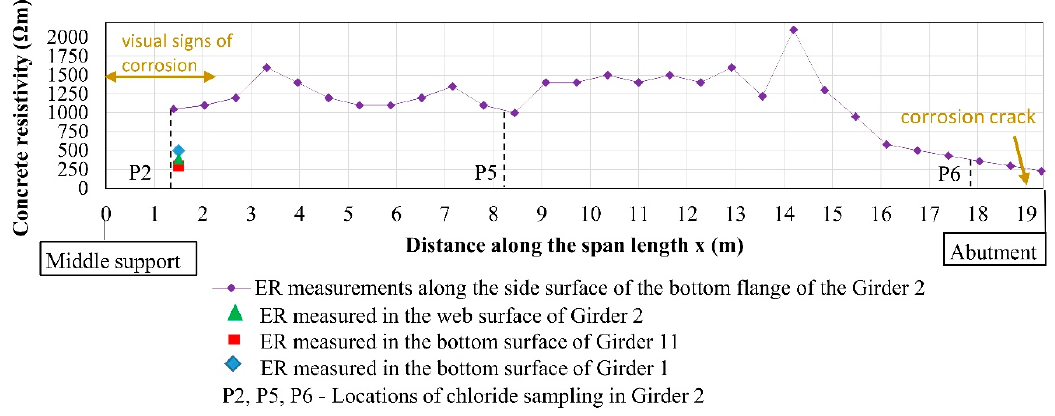
Figure 7. Concrete resistivity measured along the side surface of the bottom flange of Girder 2, in the web of Girder 2, and in the bottom surface of Girders 1 and 11 (about 1.5 m from the middle support).